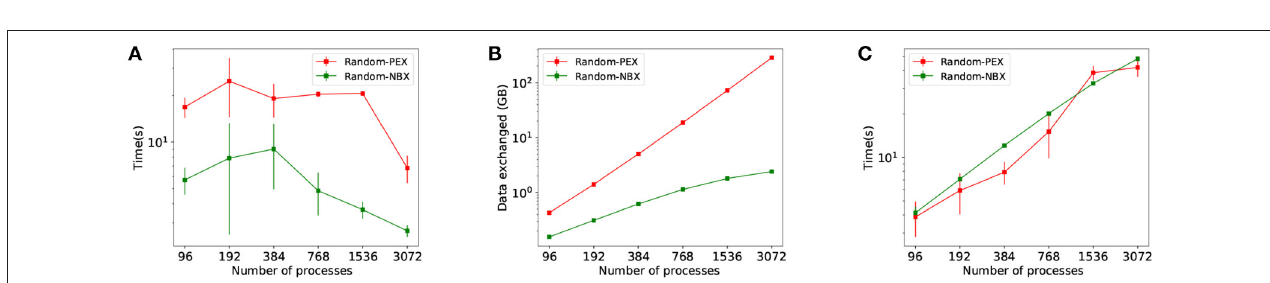
FIGURE 8 | Communication time using PEX and NBX are shown. (A) Implicit synchronization time per simulation. (B) Total volume of spiking data exchanged during simulation. (C) Data exchange time per